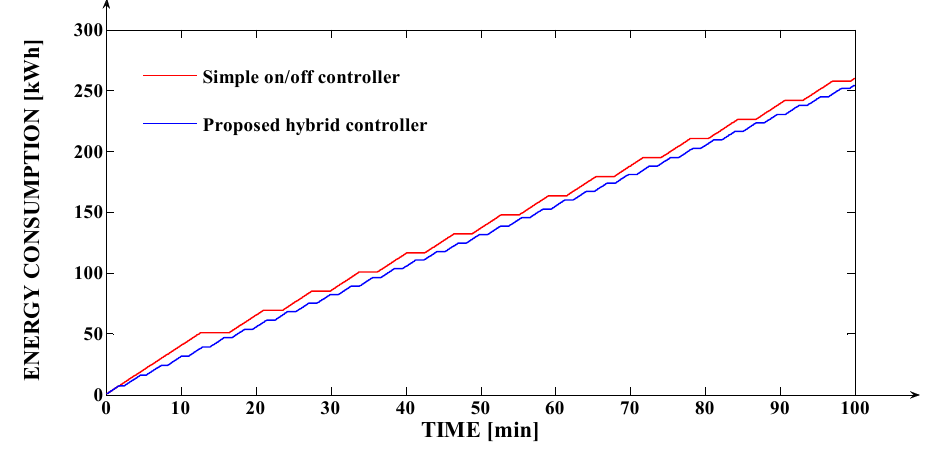
Figure 33. The energy saving analysis.